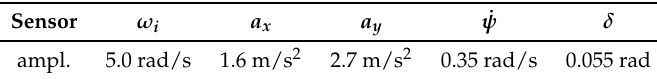
Table 3. Amplitude of detectable sensor